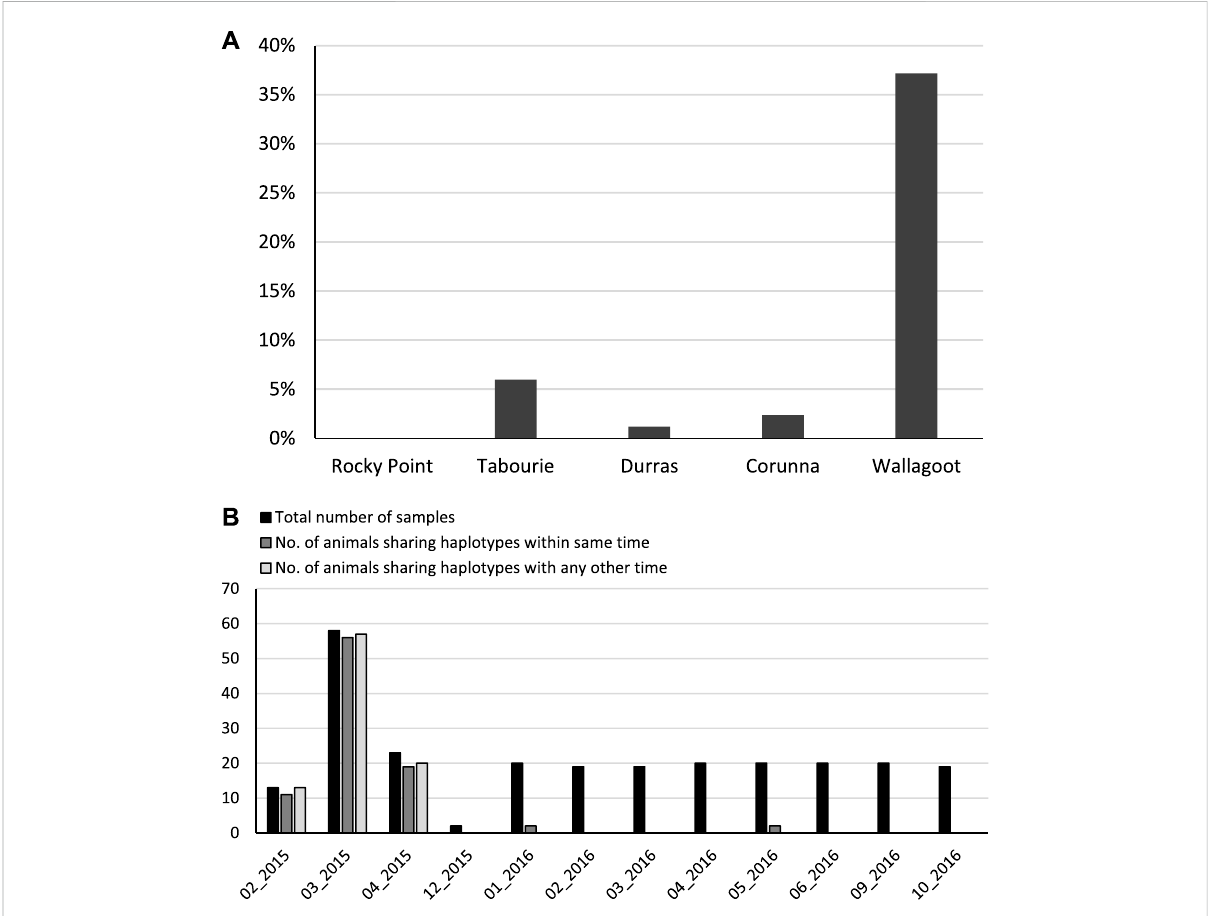
FIGURE 4 The level of mtCR haplotype sharing between animals within populations. (A) considering all populations and all samples, bars represent the percentage of animals that shared mtCR haplotypes within each population. (B) considering only the Wallagoot site, bars represent the number of animals sharing mtCR haplotypes by sample collection